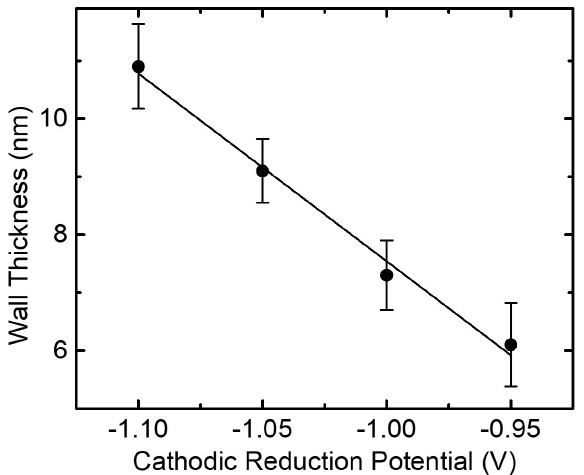
Figure 4. Graphical representation of the NTs average wall thickness dependence as a function of the cathodic reduction potential applied (versus SCE) during the electrochemical growth of Cu/Ni core/shell NWs. The measurements were acquired from the SEM analysis and the error bars represent the standard deviation ( n = 20).